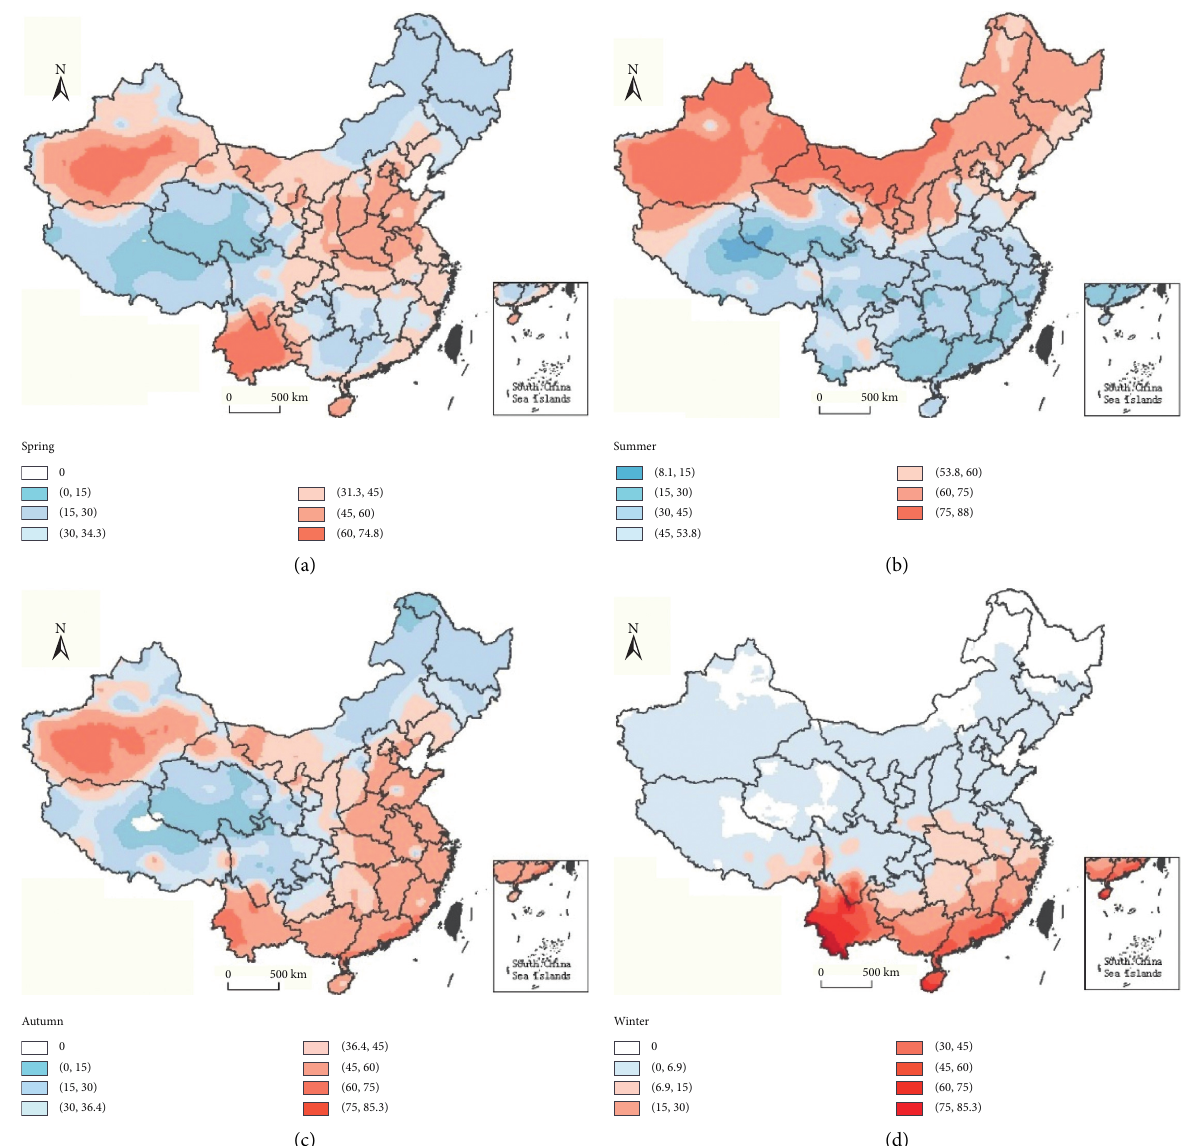
Figure 3: Spatial patterns of the seasonal average TCCP in China (1981–2010).